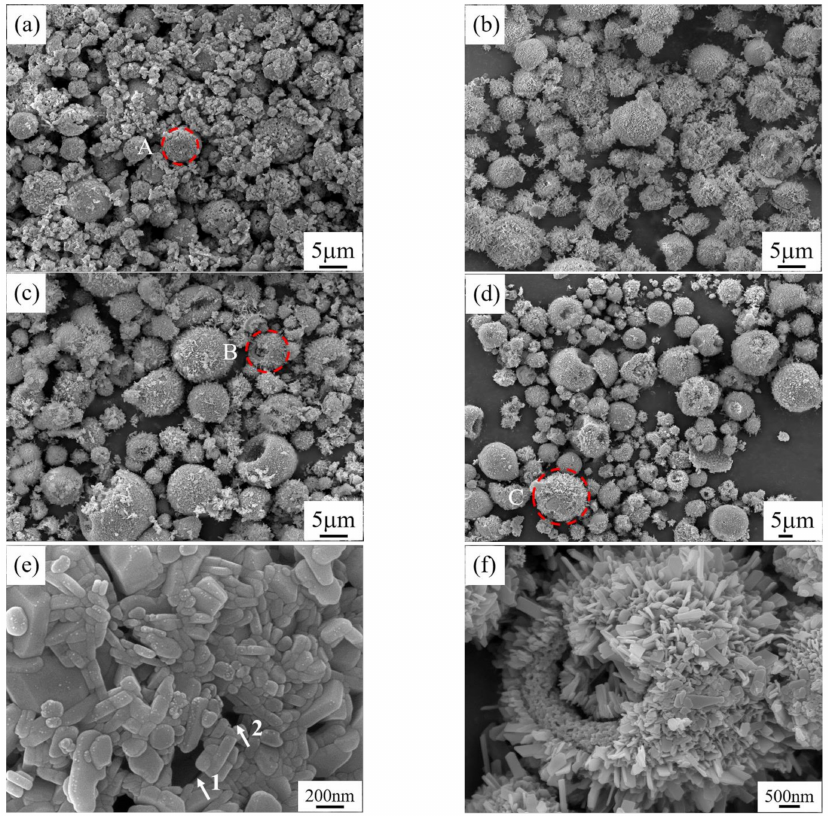
Figure 3. SEM images of precursor powders: ( a ) pure copper precursor powder; ( b ) Cu-10 wt%W precursor powder; ( c ) Cu-20 wt%W precursor powder; ( d ) Cu-30 wt%W precursor powder; ( e ) the larger version of area A in Figure 3a; ( f ) the larger version of area B in Figure